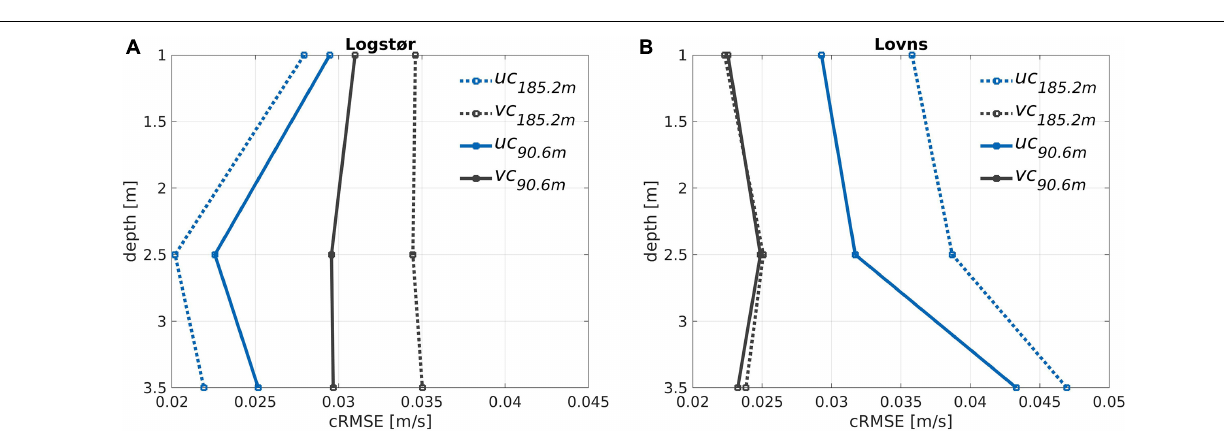
FIGURE 14 | Centered RMS Error of zonal (blue) and meridional (black) currents at Logstør (A) and Lovns (B) . Straight lines represent results of the run with standard horizontal resolution (185.2 m), whereas dotted lines represent the results of the run with double resolution (92.6